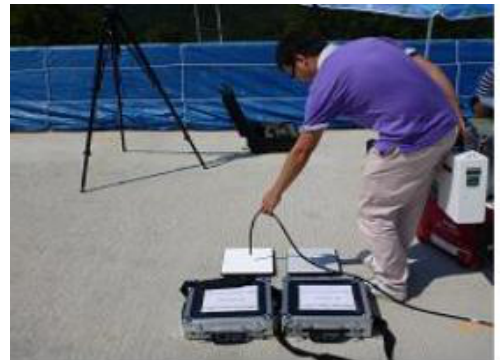
Figure 10. Data Collection using GER-3700 on Yangbuk